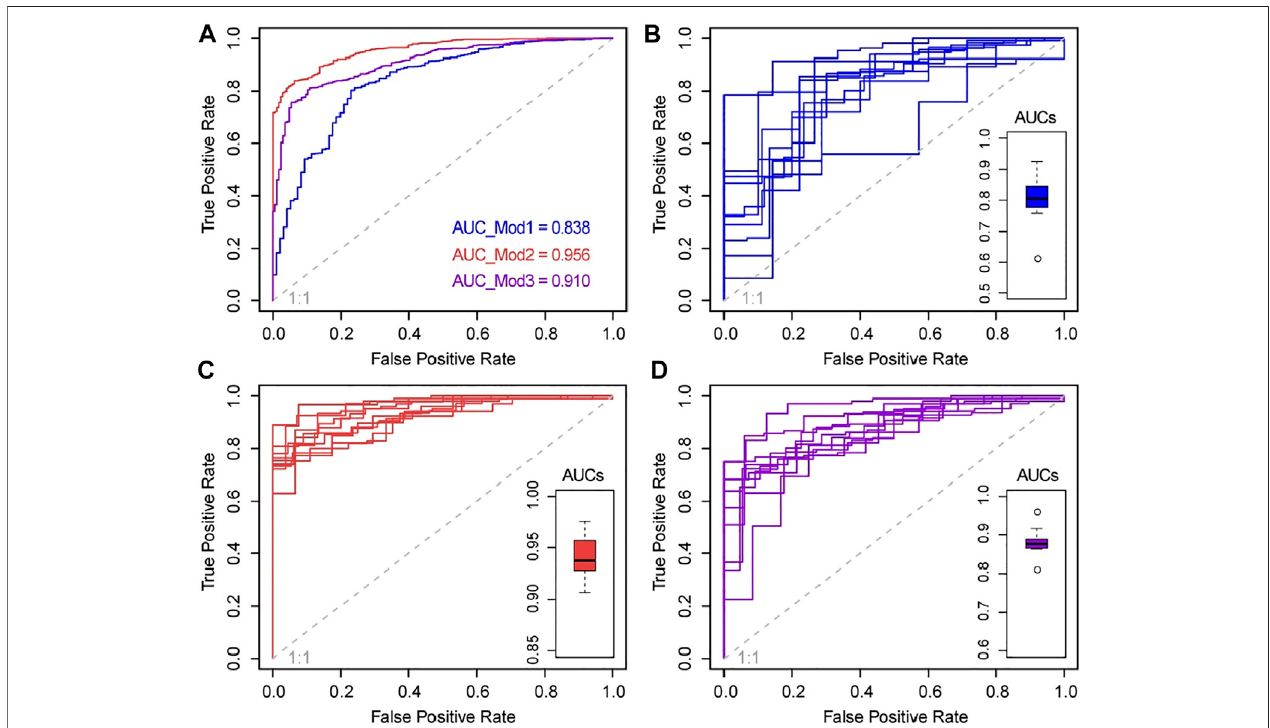
FIGURE9| Receiveroperatingcharacteristic(ROC)curvesfor (A) theactualcalibrationand10-foldcross-validationassociatedAUCvaluesdistributionboxplotfor each model corresponding to (B) Mod1, (C) Mod2, and (D) Mod3, respectively. The gray dash line is the reference line (AUC = 0.5), which represents a purely random guess.